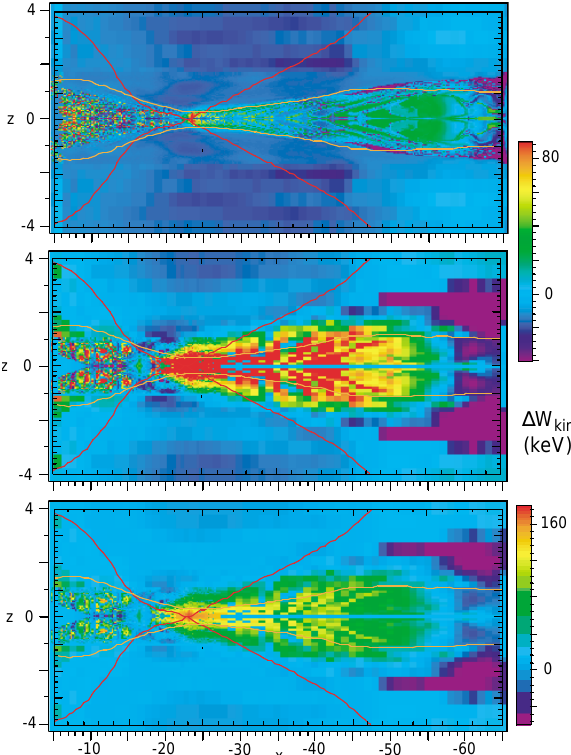
Fig. 3. Characteristics of 180 keV protons and O + fluxes in the duskward direction at y = 8 and t = 9min. The color-coding again represents the energy gain of an ion traced backwards from the given location, taken as a measure of the flux increase at the given location. The two bottom panels represent the same O + fluxes shown with different color scales. The one for the middle panel is chosen to be the same as for the protons, while the one for the bottom panel extends to the maximum energy gain, to emphasize the peak values. The red and orange lines represent the separatrices (boundaries between closed and open field lines) at y = 0 and y = 8,